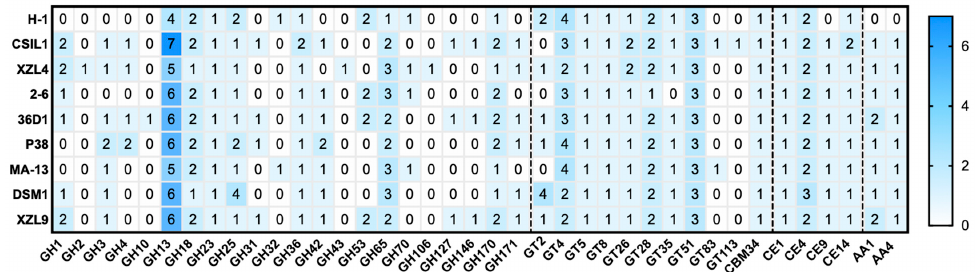
Figure 4. Heat map showing the genome-wide distribution of CAZymes in the W. coagulans strains. A total of 36 families were identified and obtained with Search with dbCAN2 HMMs of CAZy families. Blue and white represent the highest and lowest number of